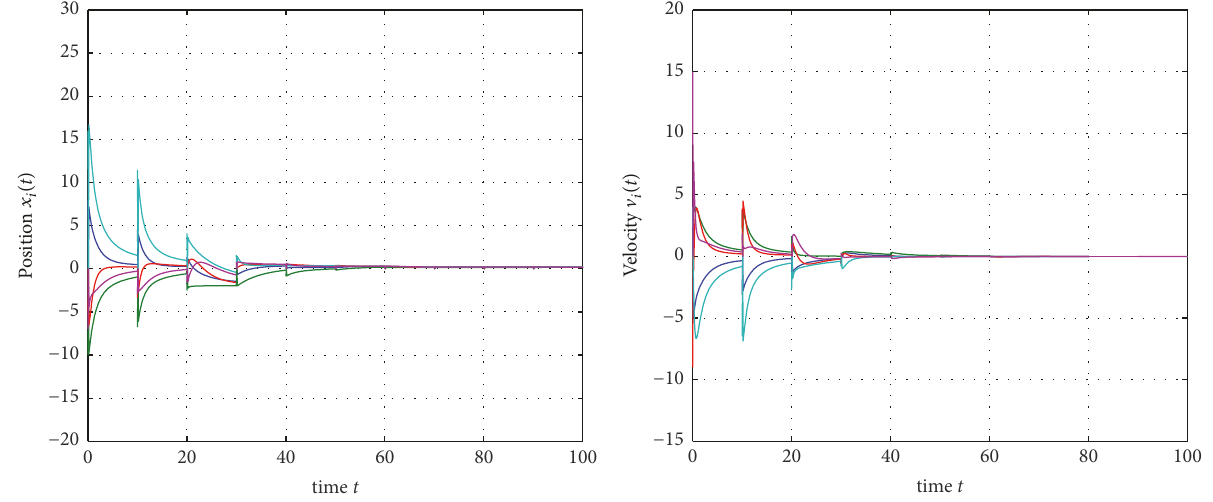
Figure 3: State responses 𝑥 𝑖 (𝑡) and V 𝑖 (𝑡) of each